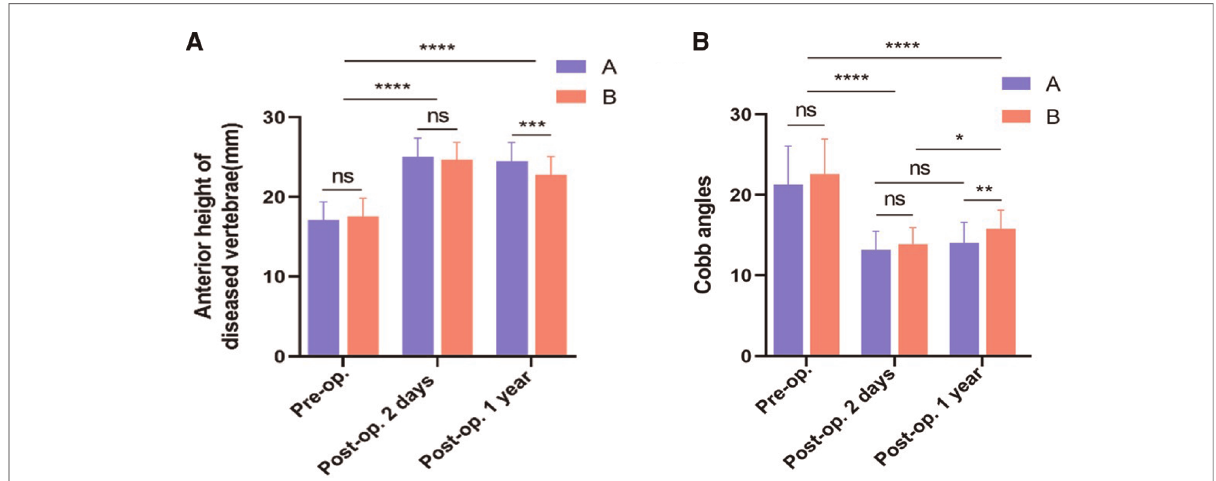
FIGURE 5 Vertebral imaging data. ( A ) Comparison of anterior height of diseased between two groups. ( B ) Comparison of Cobb angles between two groups. *, P <0.05 vs. control; **, P <0.001 vs. control; ***, P <0.0001 vs. control.